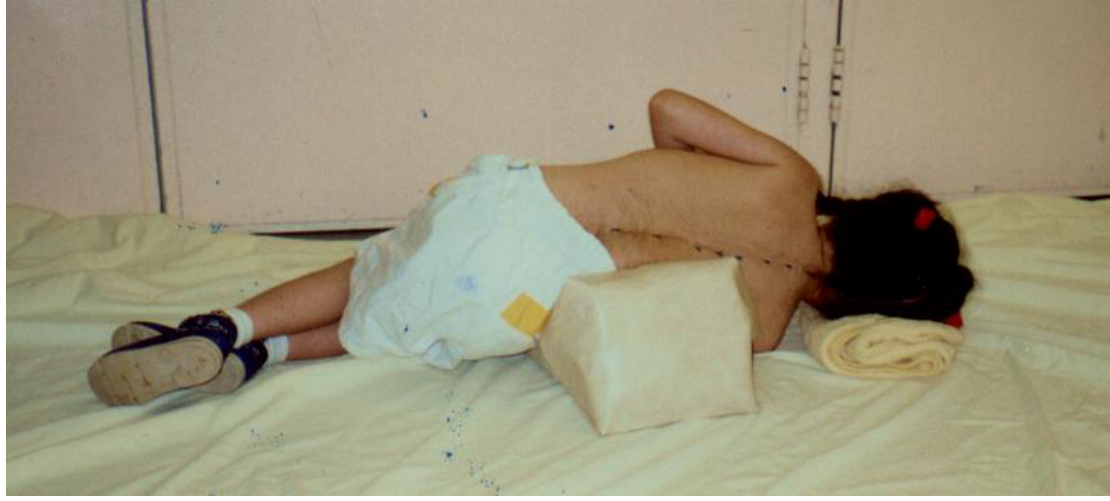
Photograph 1 . A special